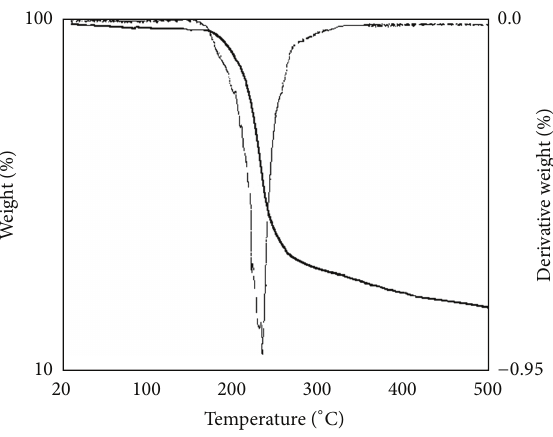
Figure 1: The TGA curve of [DABCO](SO 3 H) 2 Cl 2